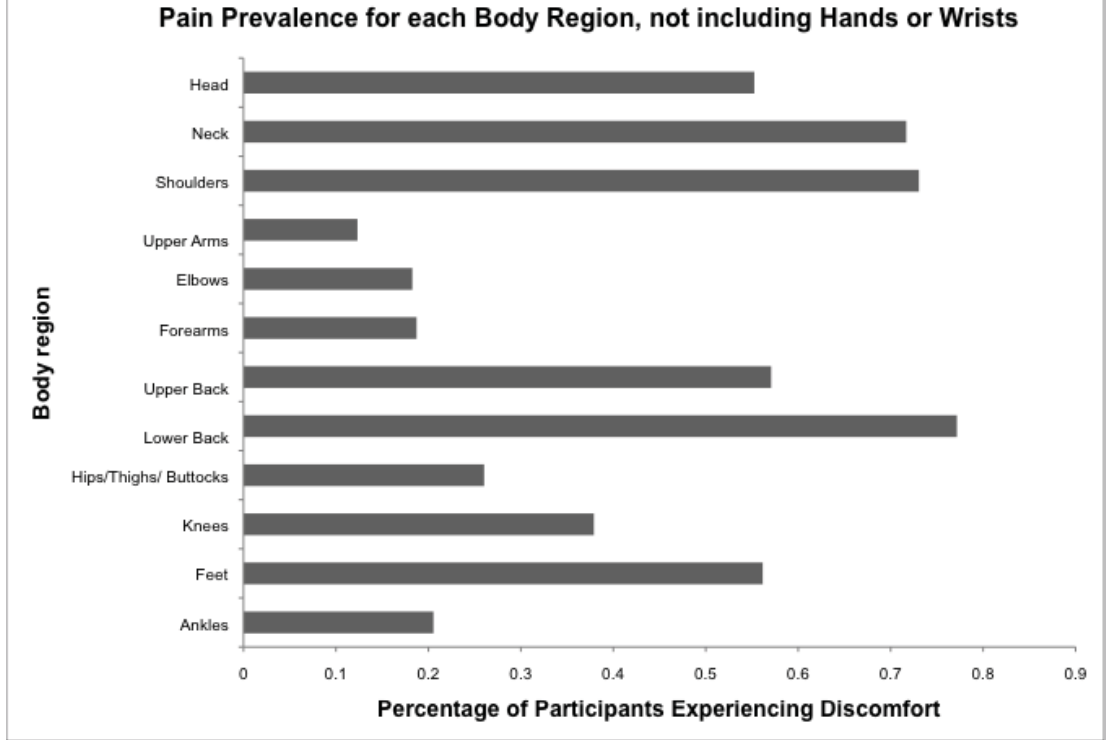
Figure 2. Percentage of participants experiencing MSD of any region of the body in the past month of spay-neuter